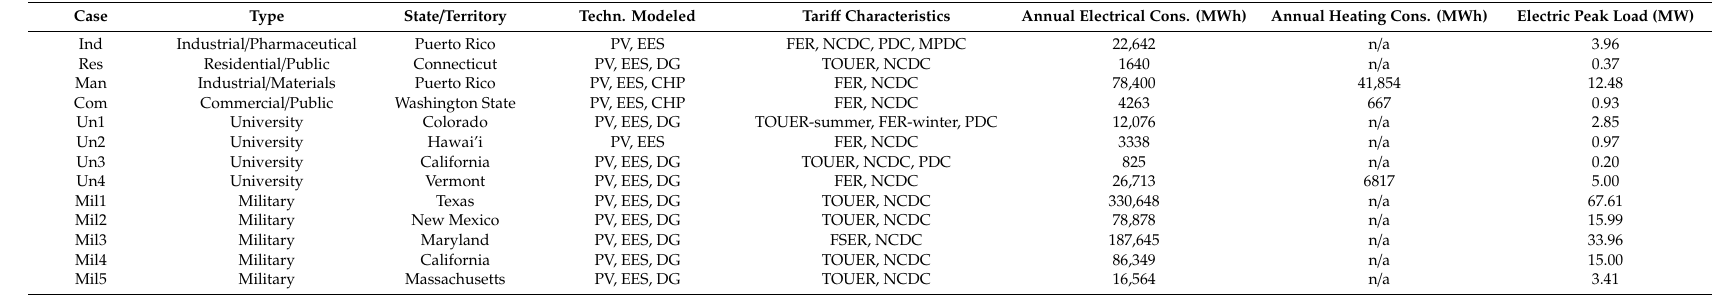
Table 1. Overview of considered Microgrid projects for this research. FER: Flat energy rate, FSER: Flat seasonal energy rate, FER-winter: Flat energy rate just for winter months, TOUER: Time-Of-Use energy rate, TOUER-summer: Time-Of-Use energy rate just for summer months, NCDC: Non-coincident demand